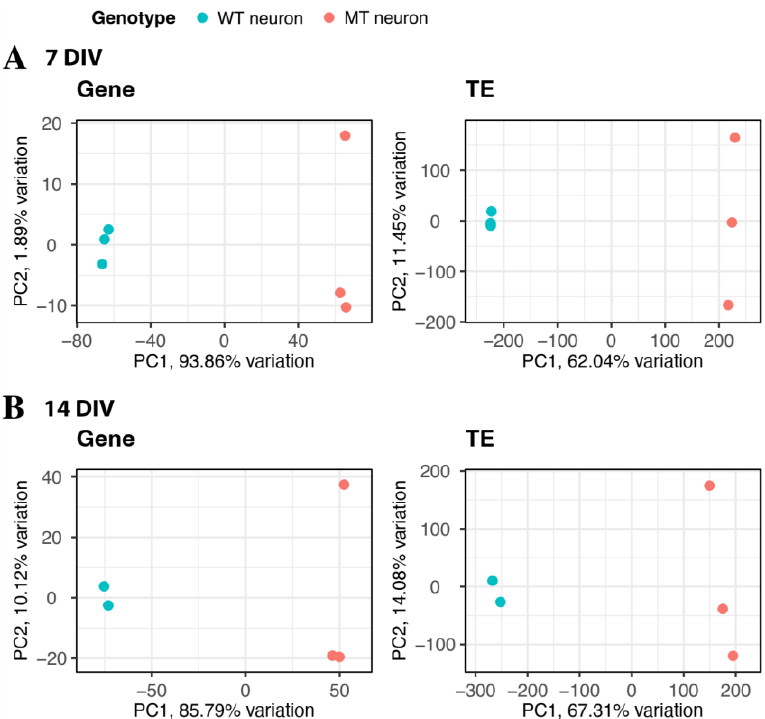
Figure 1. PCA analysis of RNA-Seq libraries for genes and TEs ( A ) PCAs corresponding to genes ( left ) and TEs ( right ) at 7 DIV ( top panels). ( B ) 14 DIV ( bottom panels) results are shown. iMNs TDP-43 WT and iMNs TDP-43 M337V samples are shown in blue and red, respectively. Despite the inherent expression variance, samples can be clustered as indicated by PCAs.